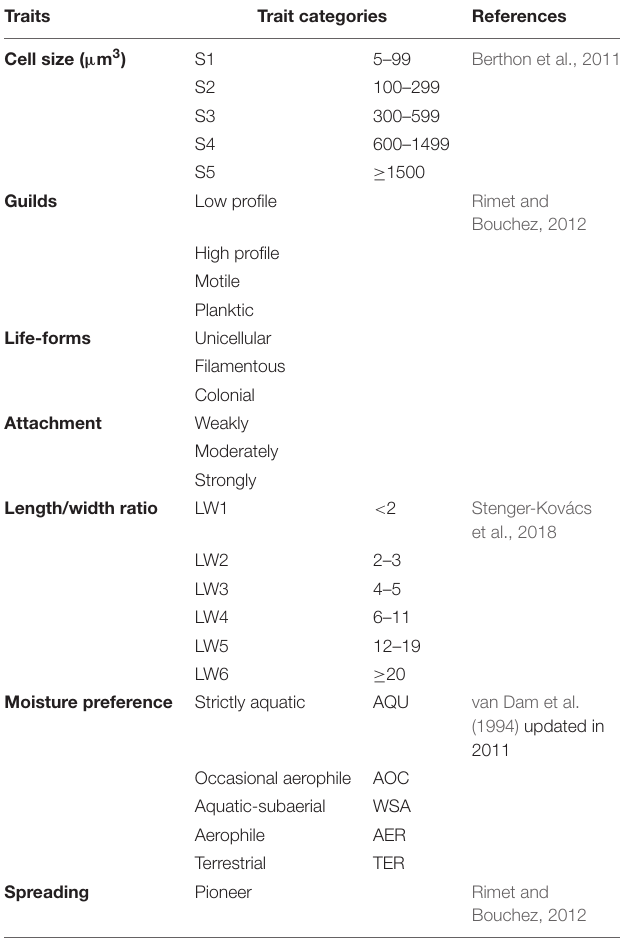
TABLE 1 | Applying functional traits and their categories and key